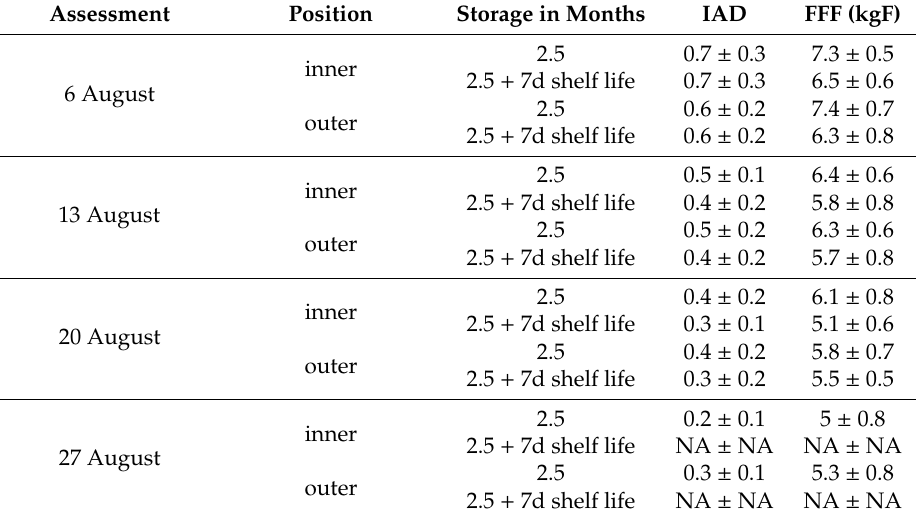
Table A3. Post-storage values of IAD and fruit flesh firmness-FFF (mean and standard deviation) of cv. ‘Gala Schniga’ apples harvested at di ff erent maturity stages.